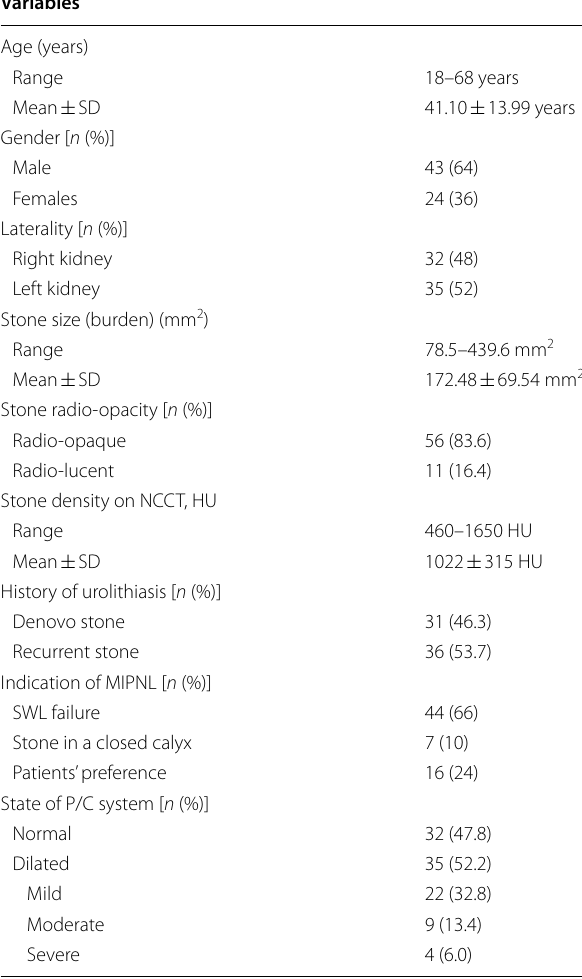
Table 1 The demographics data, clinical characteristics, and preoperative radiologic findings